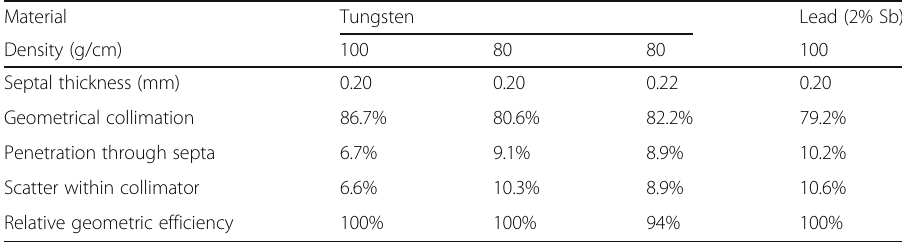
Table 7 Simulated components of scatter within energy window for different collimator materials and designs